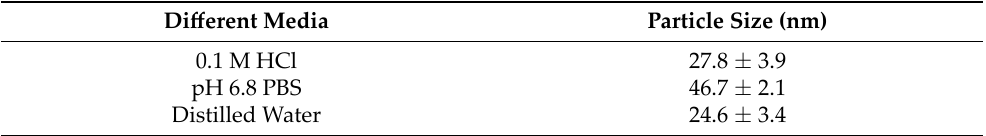
Table 8. The effects of different dilution media on the efficiency of self‑microemulsifacation of GTP‑ PC‑SNEDDS.